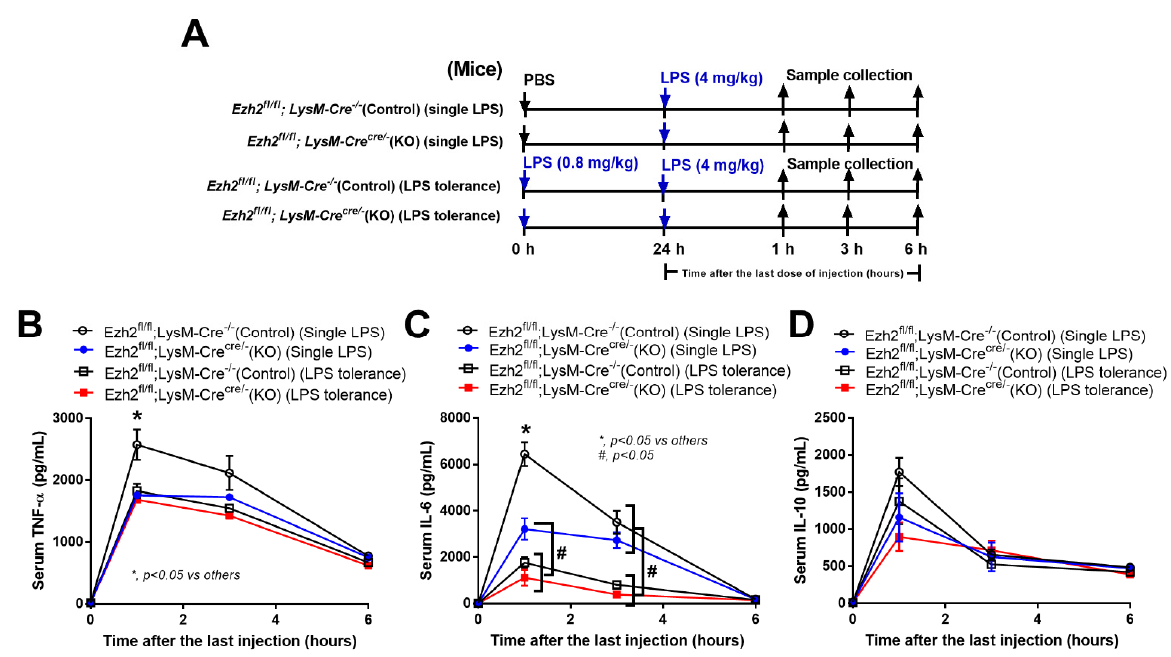
Figure 5. Schematic workflow ( A ) demonstrates the experimental groups, including lipopolysaccha- ride (LPS) tolerance; starting with LPS intraperitoneal (ip) injection (0.8 mg/kg) followed by LPS (4 mg/kg) (LPS tolerance; LPS/LPS), a single LPS stimulation; starting with phosphate buffer solution (PBS) followed by LPS (4 mg/kg) (a single LPS; N/LPS), in Ezh2 control ( Ezh fl/fl ; LysM-Cre − / − ) or Ezh2 null ( Ezh fl/fl ; LysM-Cre cre/ − ) mice as indicated by serum cytokines (TNF- α , IL-6, and IL-10) ( B – D ) ( n = 7/group or time-point). Mean ± SEM is presented with the one-way ANOVA followed by Tukey’s analysis (*, p < 0.05 vs. others and #, p <